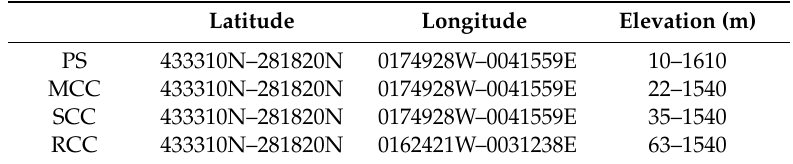
Table 2. Latitude, longitude and elevation ranges covered by the primary set and the core collections.